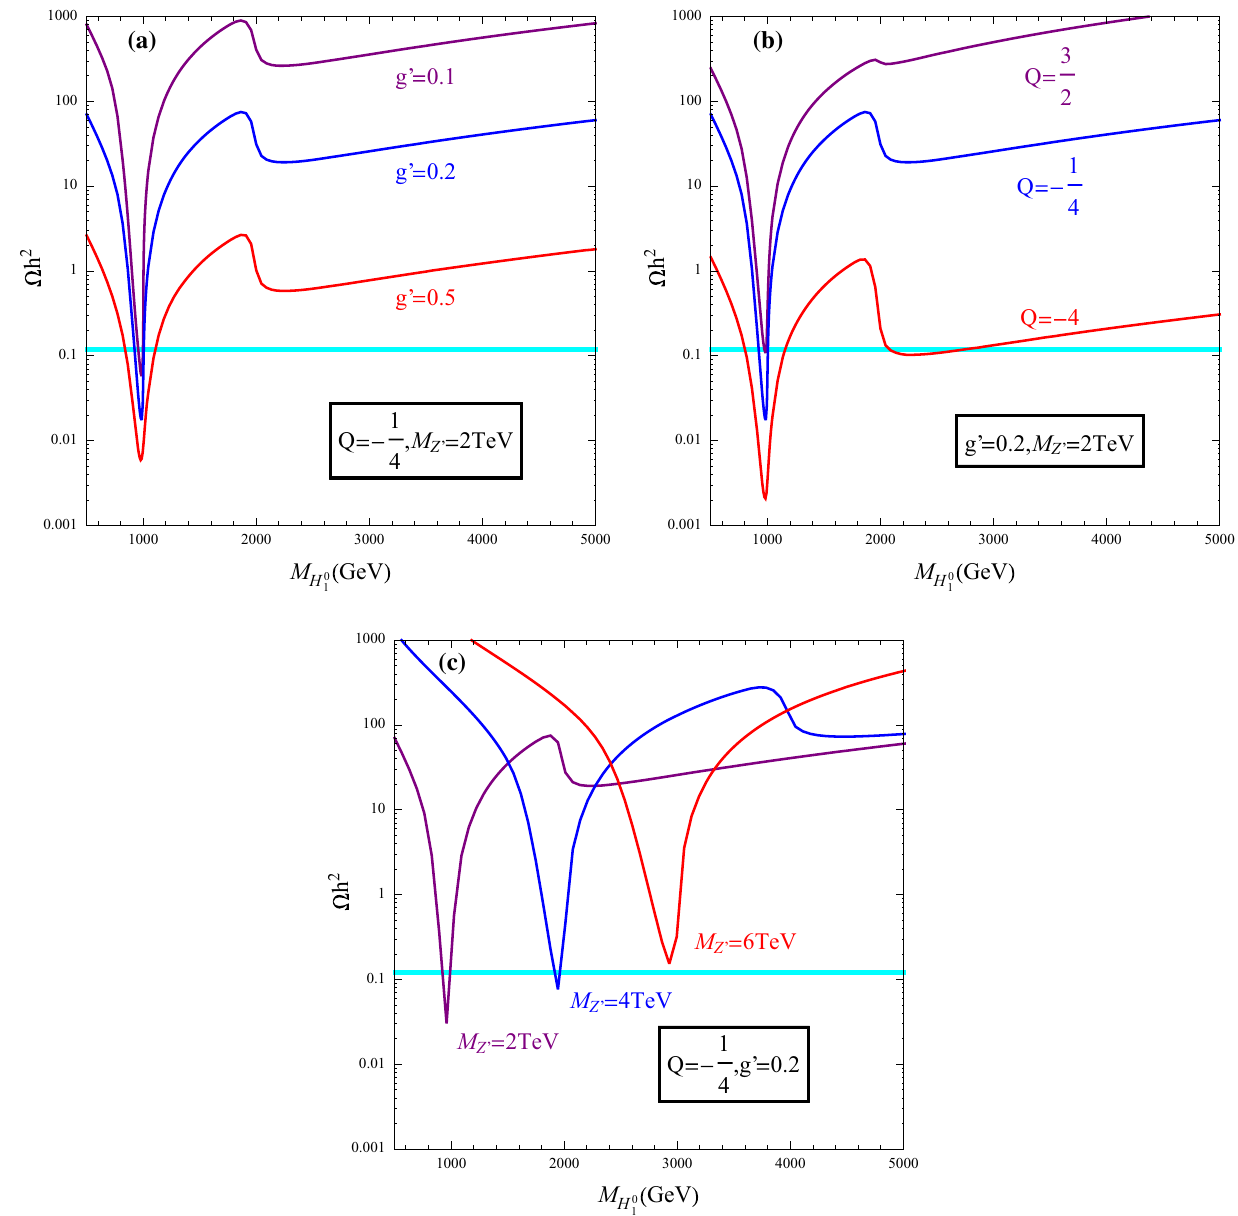
. a Q = − 1 , M Z (cid:2) = 2 TeV, g (cid:2) = 0 . 1 , 0 . 2 , 0 . 5. b g (cid:2) = 0 . 2, M Z (cid:2) = 2 TeV, H 0 1 4